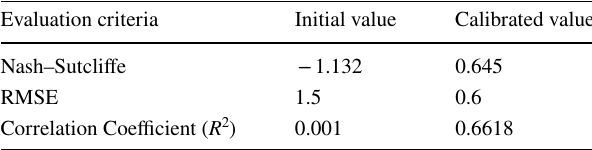
Table 17 Model-out put with their evaluation criteria Evaluation